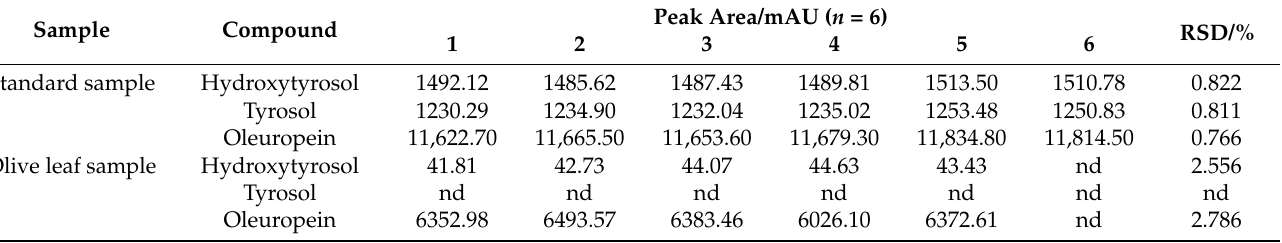
Table 2. Precision and repeatability analyses of phenolic compounds in standard and olive leaf sample at 280 nm. Sample